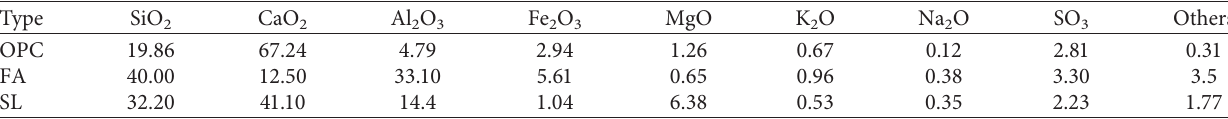
Table 1: Chemical compositions of the binder